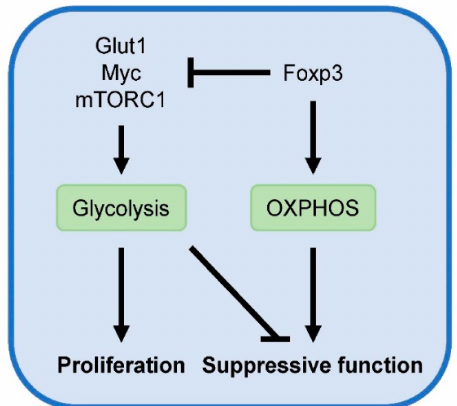
Figure 2. Metabolic regulation of Treg activity. Glycolysis fuels Treg proliferation and is associated with reduced suppressive function. Conversely, Foxp3 suppresses glycolysis and promotes OXPHOS, required for suppressive Treg